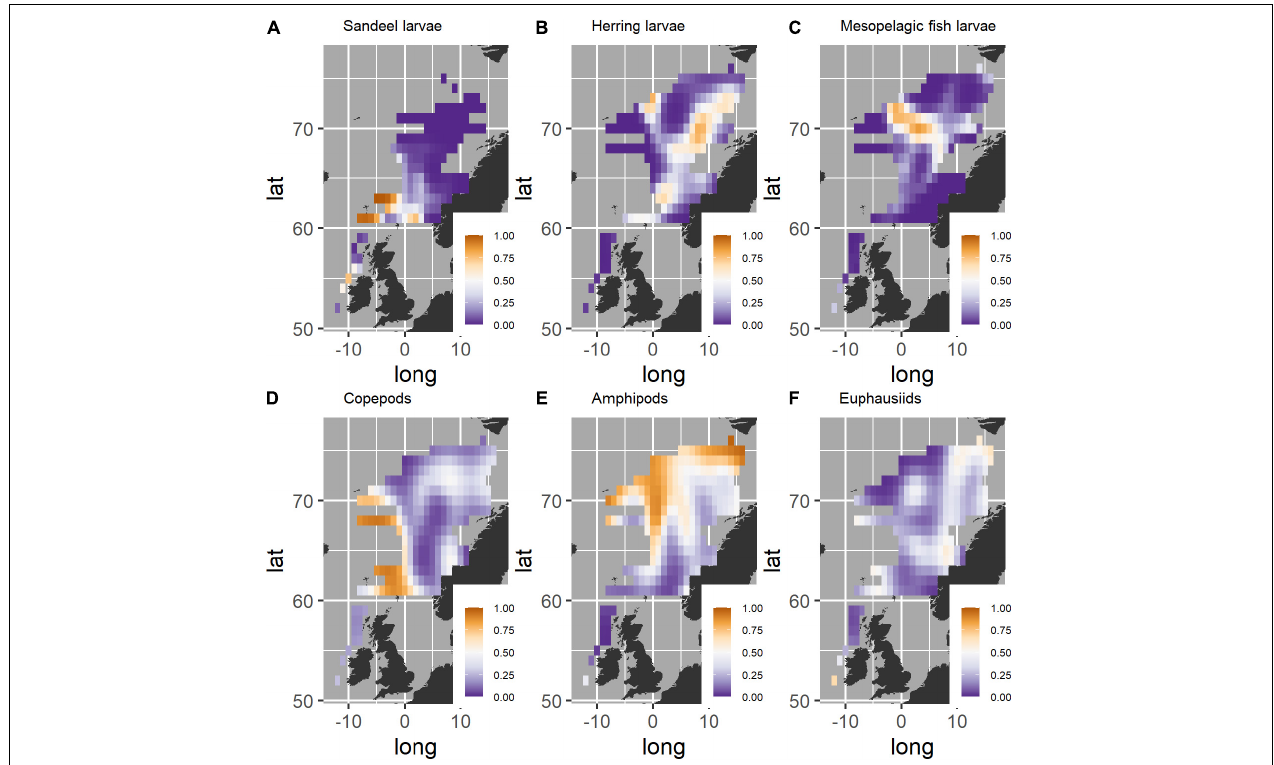
FIGURE 3 | Geographic variation in probability of finding different prey in post-smolt stomachs in areas of the Northeast Atlantic Ocean. A value of 1 indicates that the prey was found in all post-smolt stomachs in the region, while 0 indicates that the prey was not found in any post-smolt stomachs. (A) sandeel larvae, (B) herring larvae, (C) mesopelagic fish larvae, (D) copepods, (E) amphipods, (F) euphausiids. The figure was produced with the use of the following R-packages: ggplot2 (Wickham, 2016) and gridExtra (Auguié, 2017).